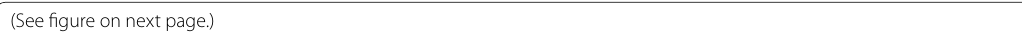
Fig. 3 The interaction between functionalized AuNRs and cells, and the multifunctional AuNRs nanoplatform composite structure. A Cells that were incubated with (a) pure culture media, (b) 20% PEG-capped AuNRs, (c) 40% PEG-capped AuNRs, (d) 100% PEG-capped AuNRs, (e) 100% CTAB-capped AuNRs and stained with fluorescein diacetate (FDA), (f) cytotoxicity of AuNRs in HCC cell line. Reproduced with permission from Ref. [54]. Copyright 2019, Wiley Online Library. B (a) Specific uptake by immortalized normal primary mouse hepatic stellate cells (GRX) of AuNRs-PEG (panels d–f) and AuNRs-PDGFRβ (panels g–i) determined by TPL means. Bright-field and TPL merged images are shown demonstrating intracellular localization of AuNRs taken up. (b) Quantification of TPL signals from GRX cells incubated without AuNRs, with AuNRs-PEG and with AuNRs-PDGFRβ. Six fields of each condition were imaged and averaged. Data mean SEM.* indicates statistical differences compared to control group, and # ± compared to AuNRs-PEG, with p < 0.0001. Reproduced with permission from Ref. [60]. Copyright 2021, ACS Publication. C Synthesis procedure